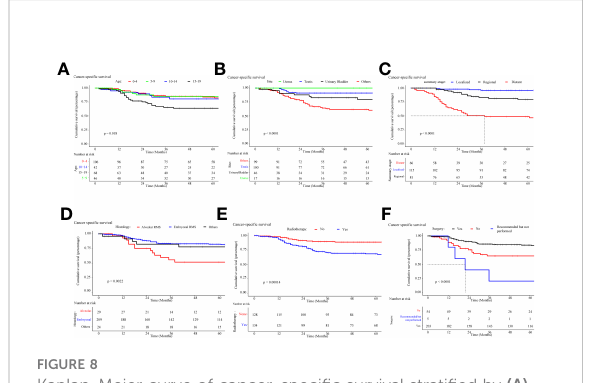
FIGURE 8 Kaplan-Meier curve of cancer-speci fi c survival strati fi ed by (A)